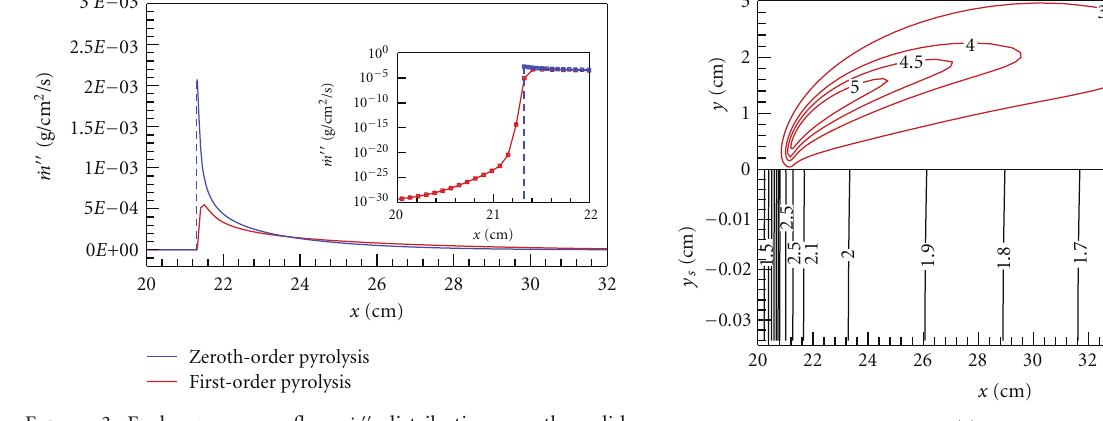
Figure 3: Fuel vapor mass flux, ˙ m (cid:3)(cid:3) distributions on the solid surface for both pyrolysis models. In the inset, a log-scale ordinate is use d.